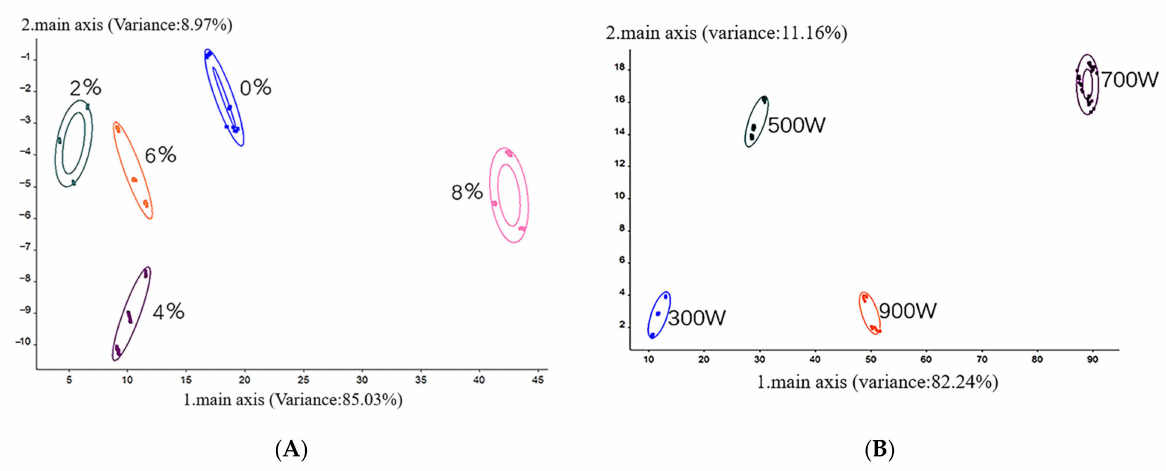
Figure 5. PCA diagram of volatile components in dried samples with different salt concentrations ( A ) and MW powers ( B